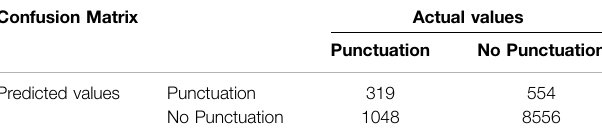
TABLE 3 | Confusion Matrix of Punctuation